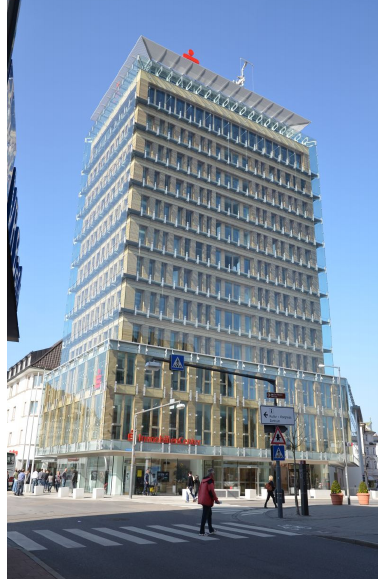
Figure 16. Transsolar Project—Sparkasse Rosenheim: Reprinted with permission from © Transsolar.